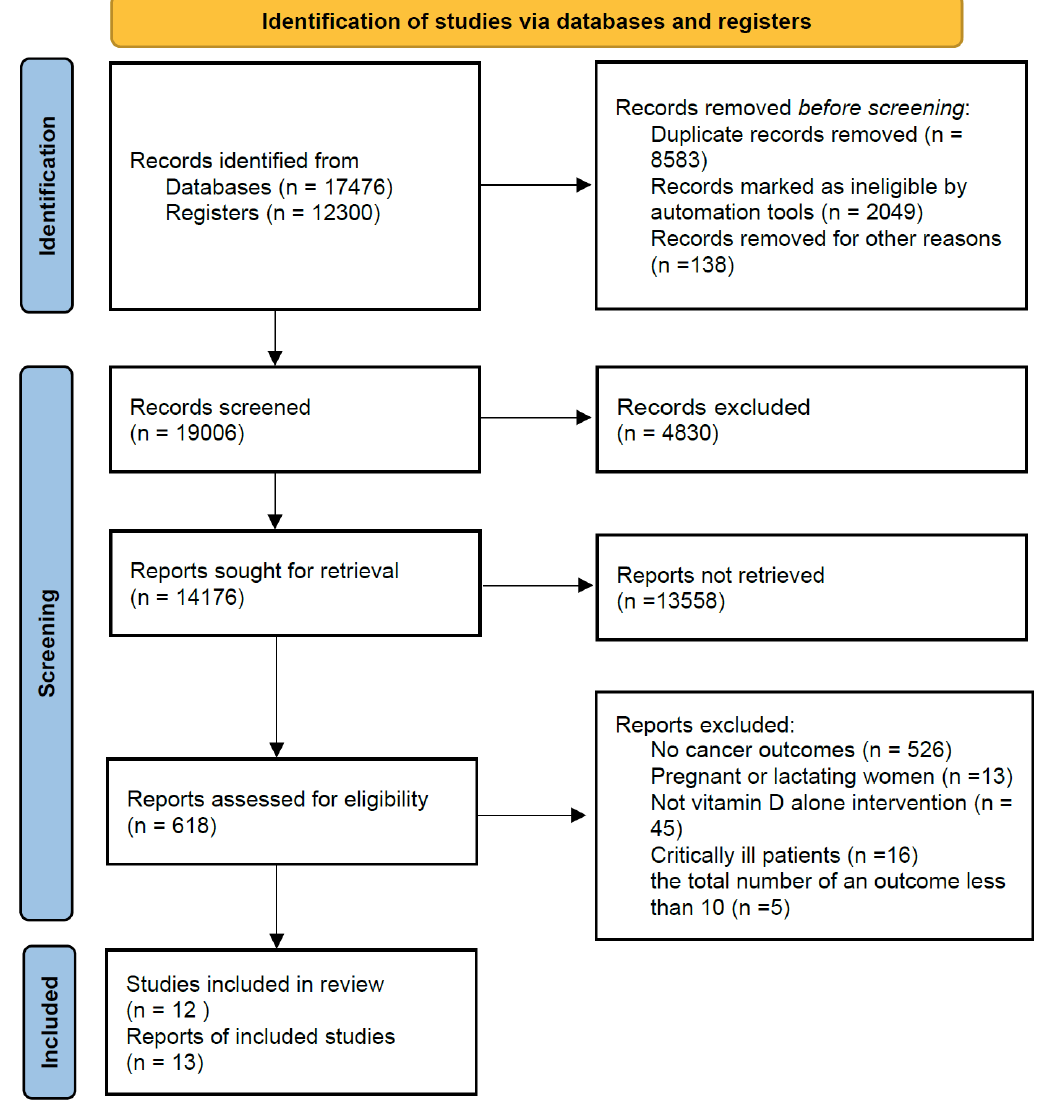
Figure 1. Flowchart for study selection.